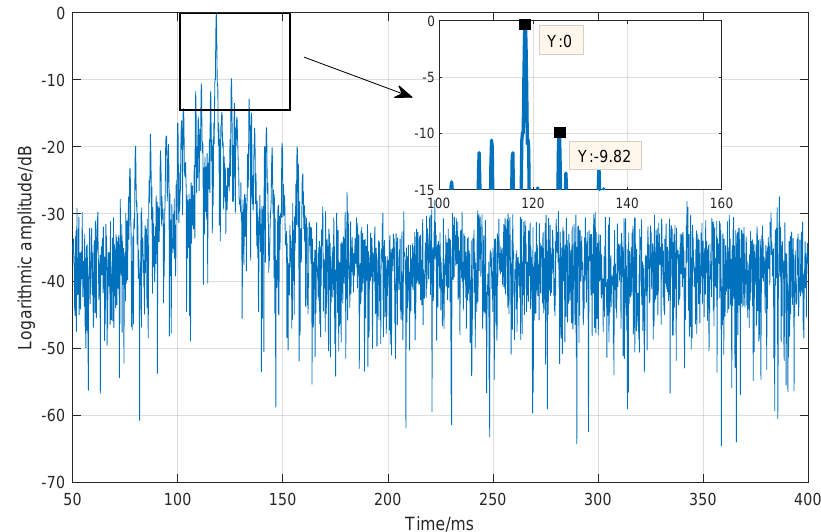
Figure 8. The result of received signal processed by